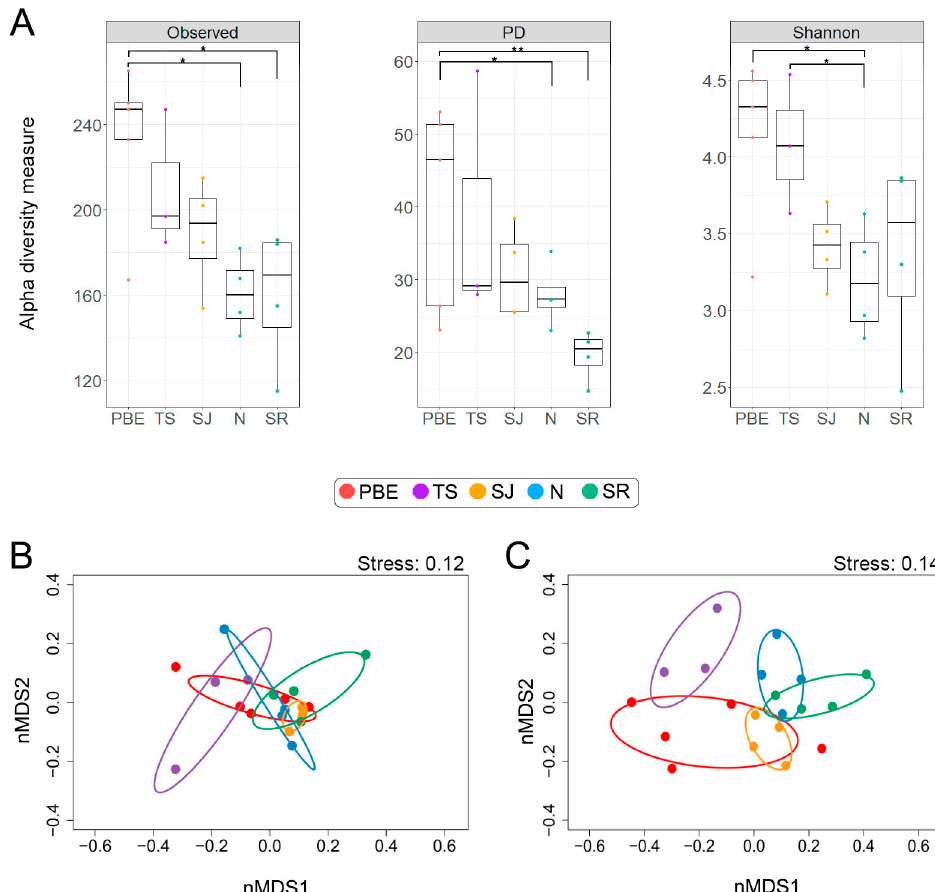
Fig 3. Comparison of the gut microbiome of the different harbor seal colonies. (A) Alpha diversity was measured by means of observed OTUs, phylogenetic diversity (PD) and Shannon index values. Non-metric multidimensional scaling analysis (nMDS) conducted for the weighted (B) and unweighted (C) UniFrac distance matrix. Ellipses correspond to a confidence area of 98% based on the standard error for the weighted and unweighted UniFrac metric. PBE = Punta Banda Estuary, TS = Todos Santos Island, SJ = San Jeronimo Island, N = Natividad Island, SR = San Roque Island. � p < 0.05, �� p < 0.01.